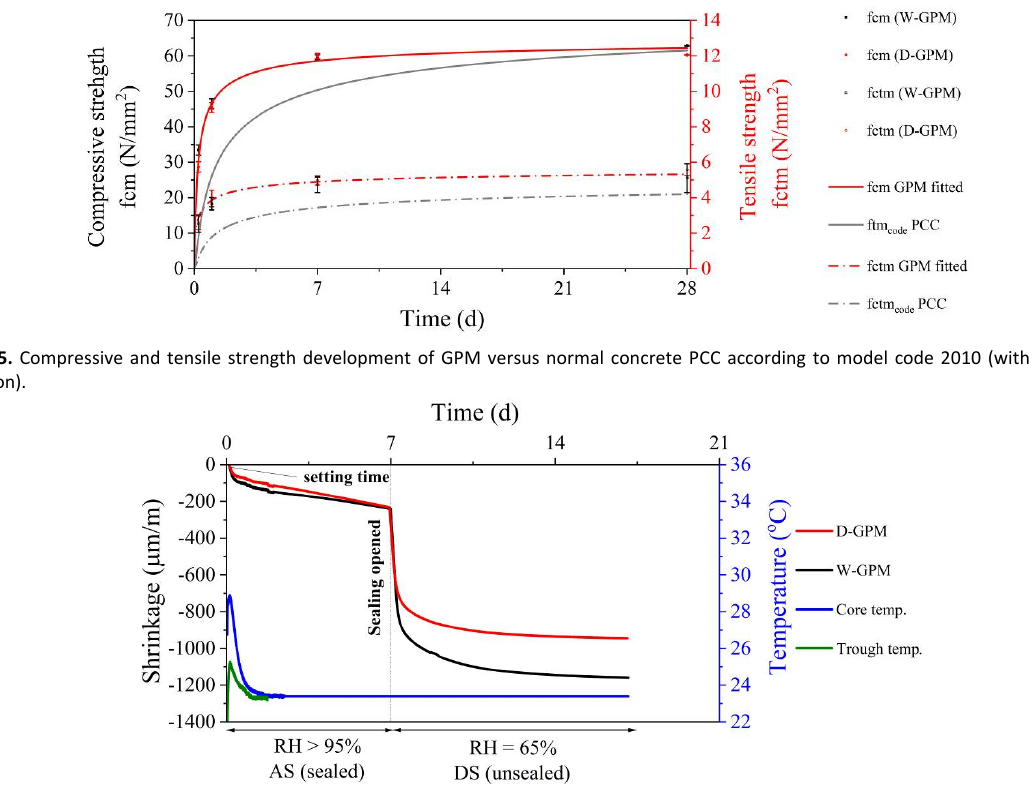
Figure 6. AS measured under sealed conditions in the first period (0 ‐ 7 d); DS measured under 50% RH at 23 °C subsequently (7 ‐ 17 d) with the unsealed shrinkage trough. Additionally, temperatures of GPM in the core of the specimens and of the inner bottom of the steel trough are